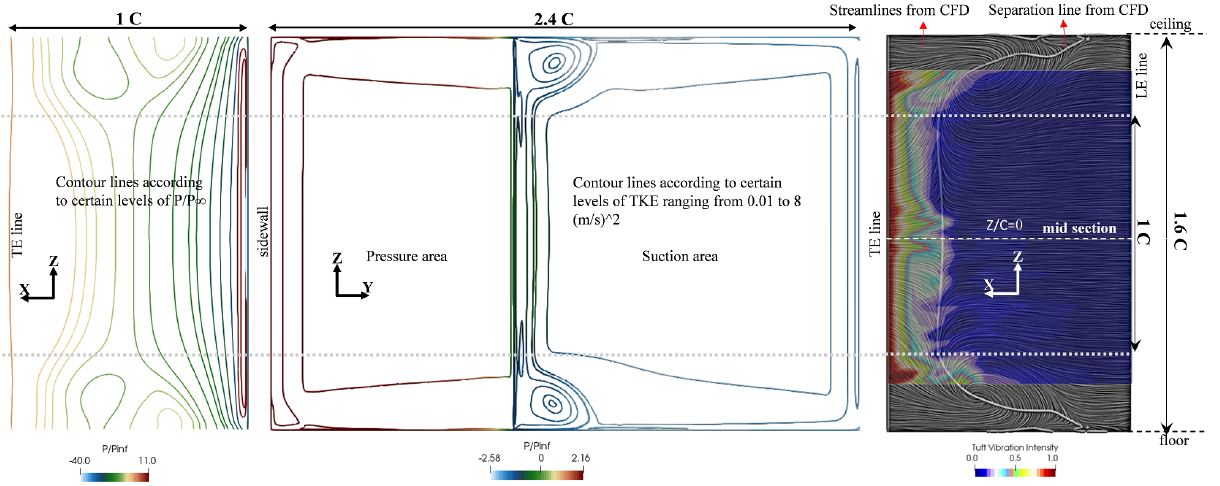
Figure 14. Three-dimensional effects due to the floor and ceiling via CFD contour lines and tuft visualization at AOA = 11 ◦ ; ( left ) (XZ): Suction surface of the wing; ( middle ) (YZ): wake-plane normal to the streamwise flow at X/C = 0.01 (similar plane as in Figure 12); ( right ) (XZ): Suction surface of the wing with tuft visualization with the CFD plots in the background. The continuous dashed line shows the same location of the vortex in the three shown